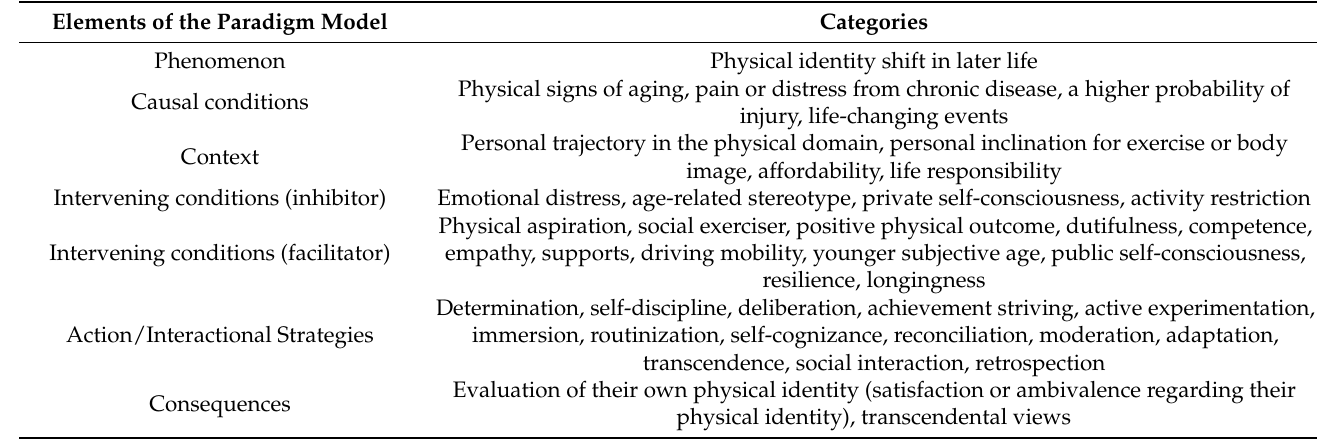
Table 2. Utilizing the paradigm model in axial